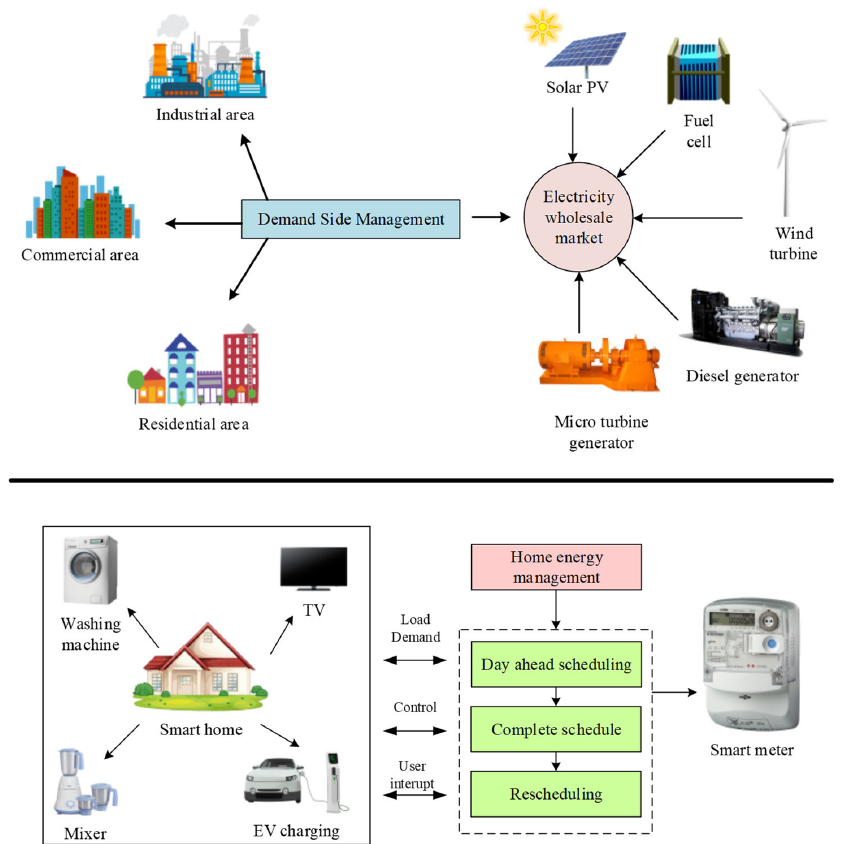
Figure 2. Overview of Demand Side Management in MG.